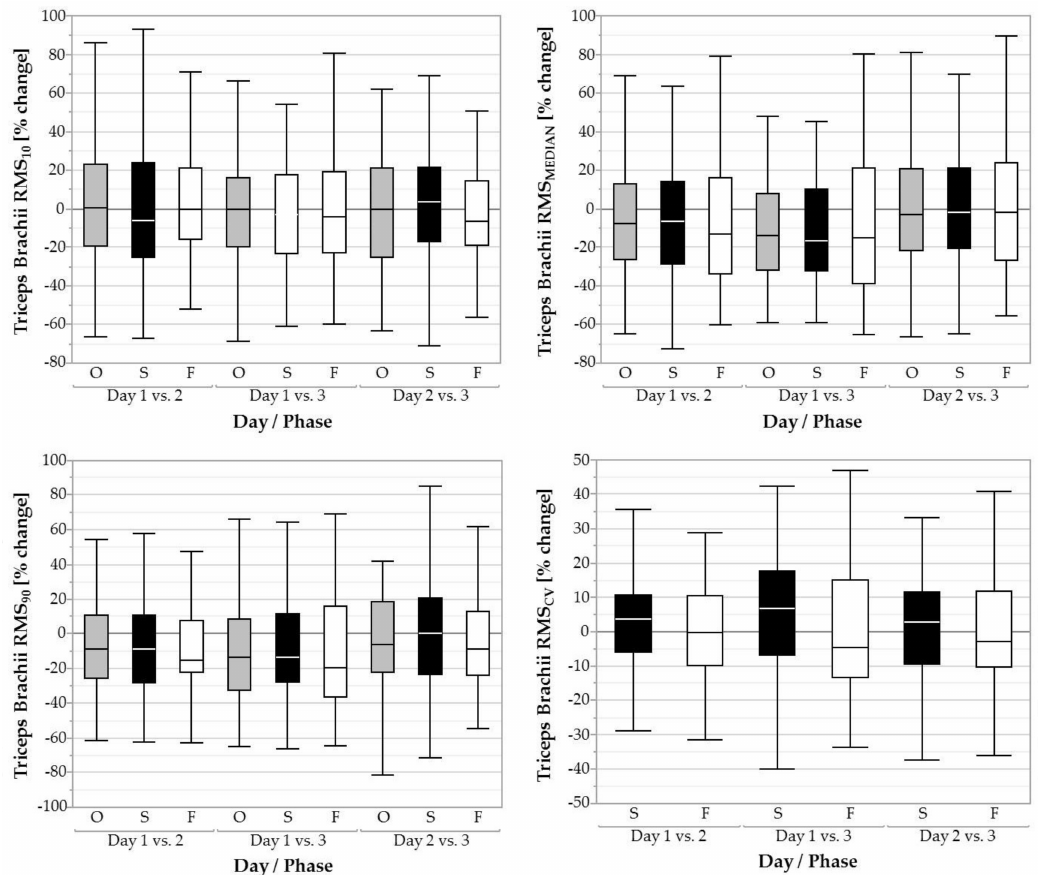
Figure 2. Boxplots of the 10th, 50th, and 90th percentile muscular activity (RMS 10 , RMS MEDIAN , RMS 90 ) and coefficient of variation (RMS CV ) of the triceps brachii over three days for the overall task (O, grey filled boxplots), the screwing phases (S, black filled boxplots), and the fastening phases (F, white filled